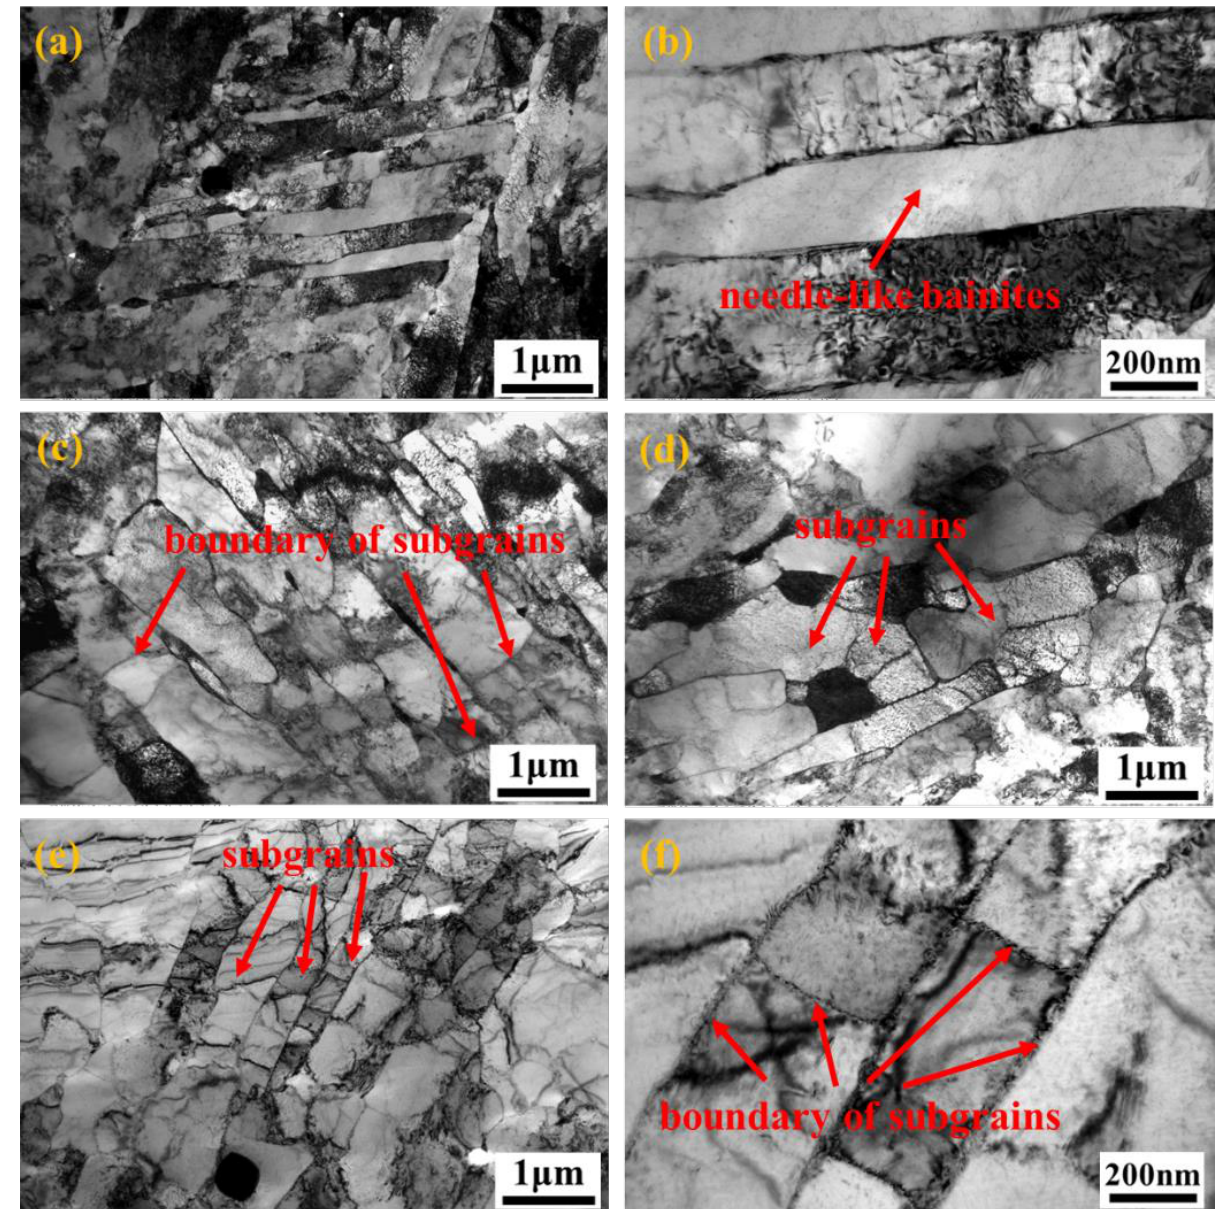
Figure 7. The typical TEM microstructures of the as-received and the LCF damaged WM specimens with different strain amplitudes: the as-received specimens ( a , b ) was the local enlargement in ( a ), the LCF damaged specimens with the strain amplitude of ±0.3% ( c ), ±0.5% ( d ), ±0.8% ( e , f ) was the local enlargement in ( e ).